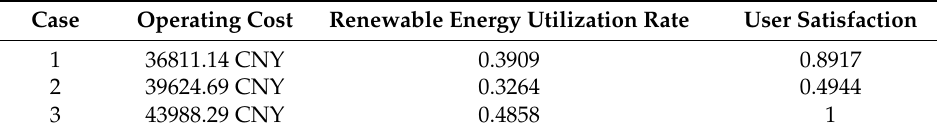
Table 2. Comparison of objective function values of different cases.